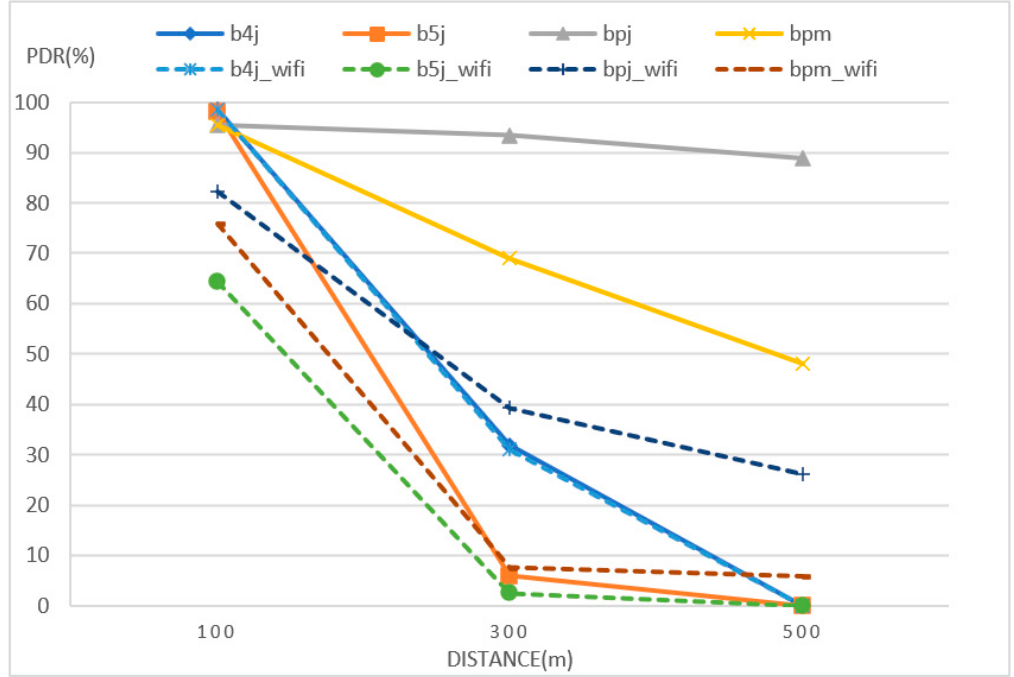
Figure 12. PDR(%) results between normal operation and WiFi coexistence.